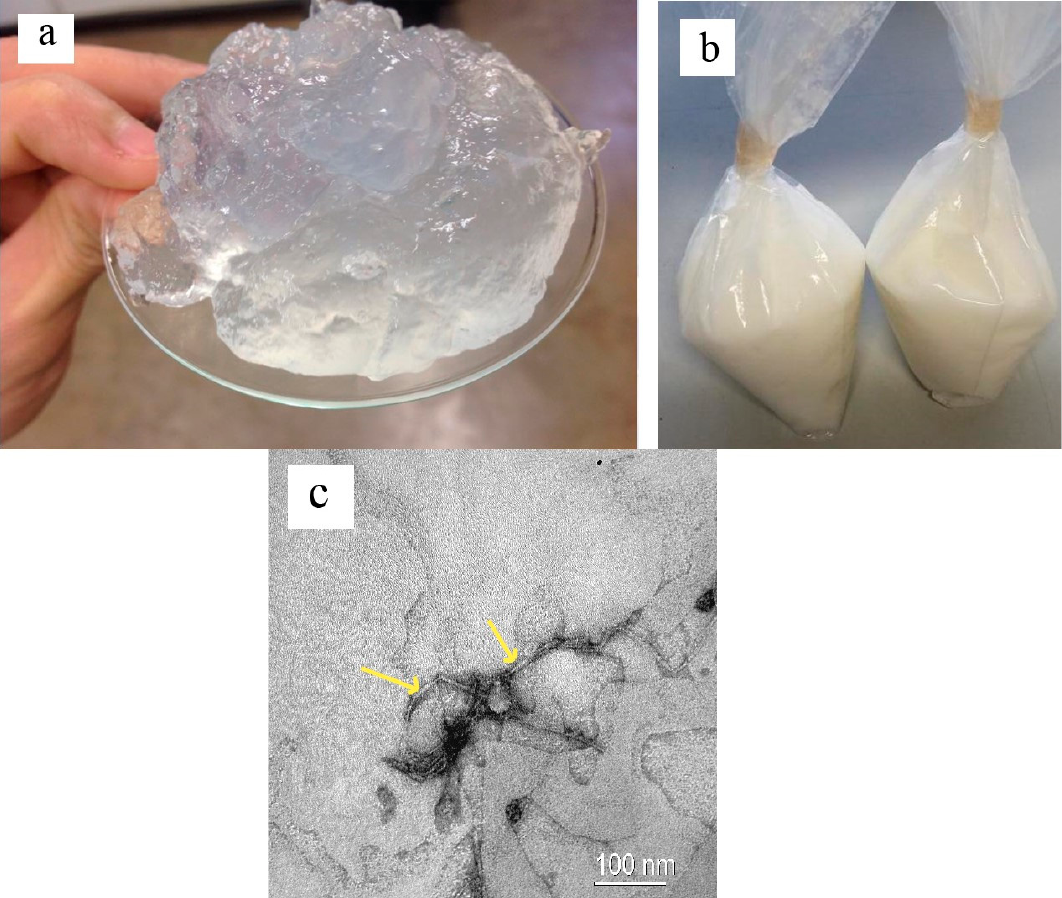
Figure 1. ( a ) Gel based on nanofibrillated cellulose (CNF) BEP dispersed in glycerol (gly) (1% w / w of concentration); ( b ) mixture of native starch + CNF BEP dispersion in glycerol + distilled water inside the linear low-density polyethylene (LLDPE) bags; ( c ) transmission electron microscopy (TEM) picture of the gly- CNF BEP gel. BEP, bleached eucalyptus pulp. Polymers 2020 , 12 , x FOR PEER REVIEW Table 1. Composition and nomenclature of thermoplastic starch films reinforced with CNF BEP fibers.